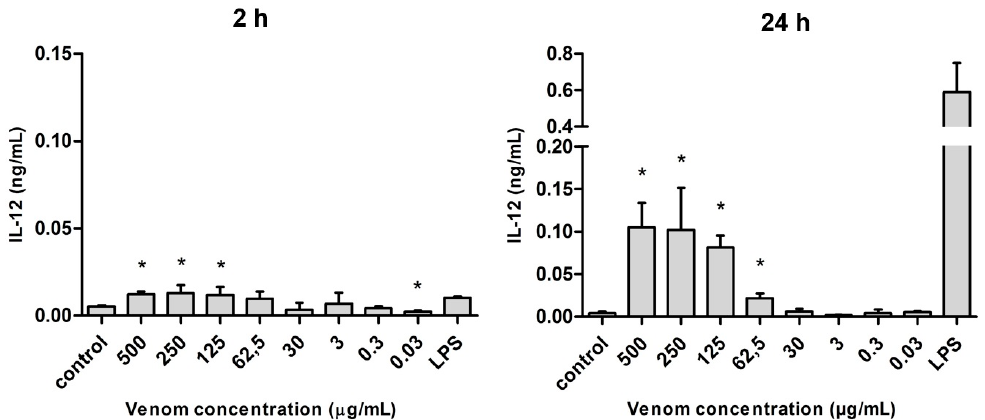
Figure 6. Amount of IL-12 (in ng/mL) released after the stimulus with Neoponera villosa venom Values expressed in mean + standard deviation. Control: macrophages with supplemented culture medium